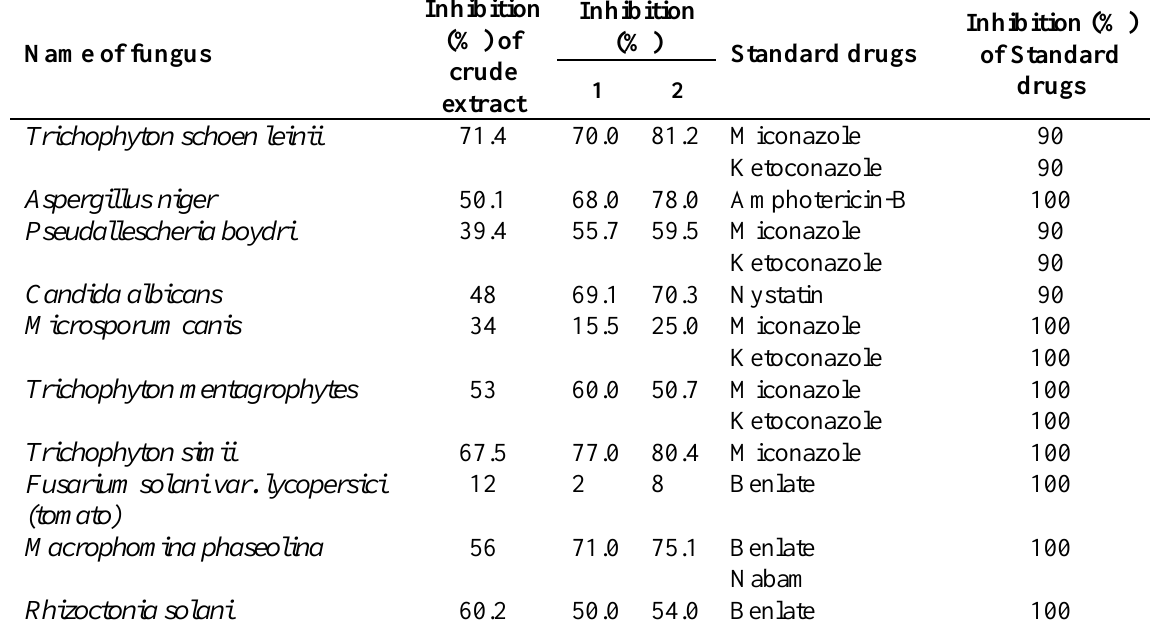
Inhibition Inhibition (%) (%)